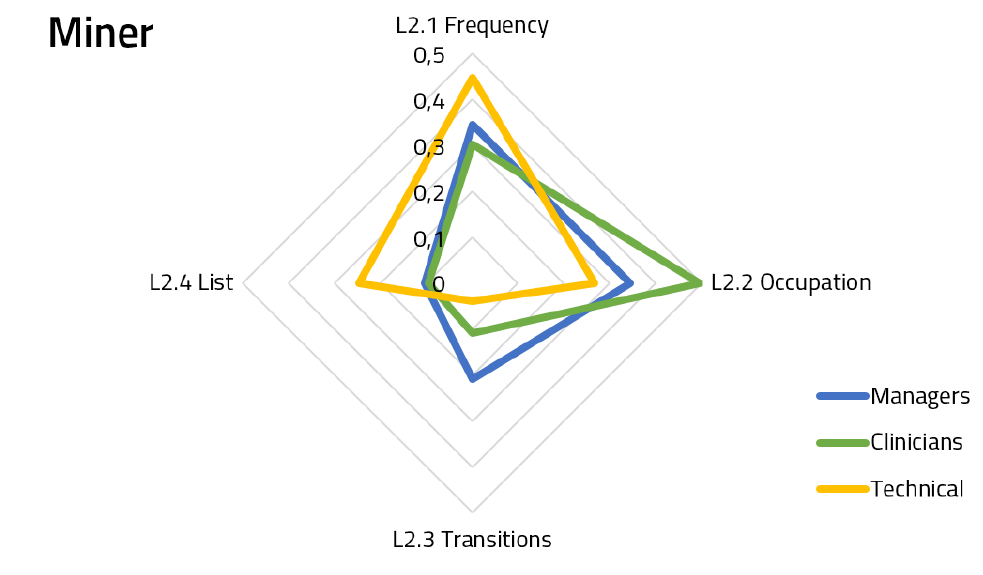
Figure 6. Priorities for miner functional module